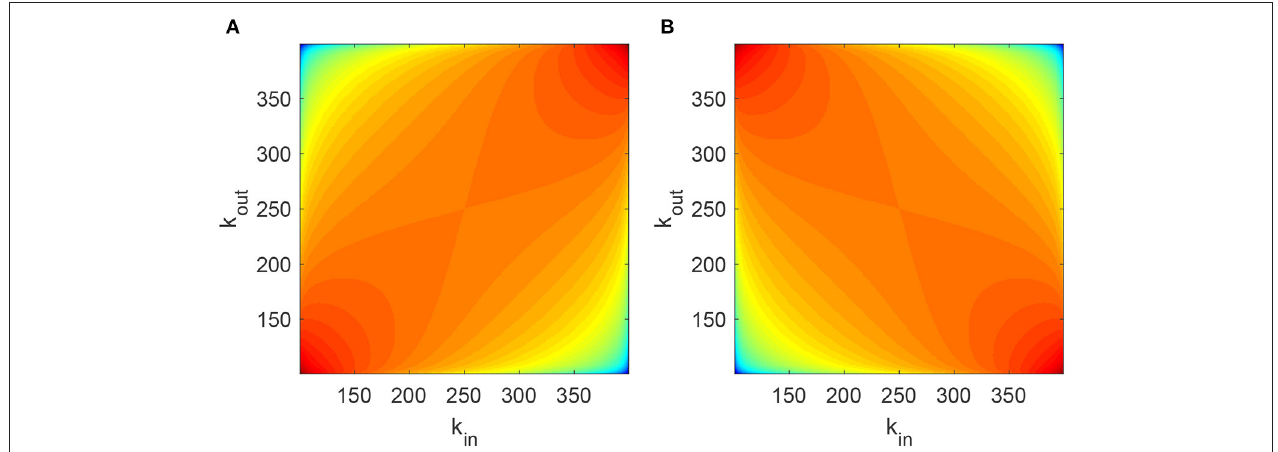
ρ ) for (A) ρ ρ 0.5 and (B) 0.5. The log of P is shown, with red corresponding to higher values and blue to lower. ˆ ˆ = ˆ = −